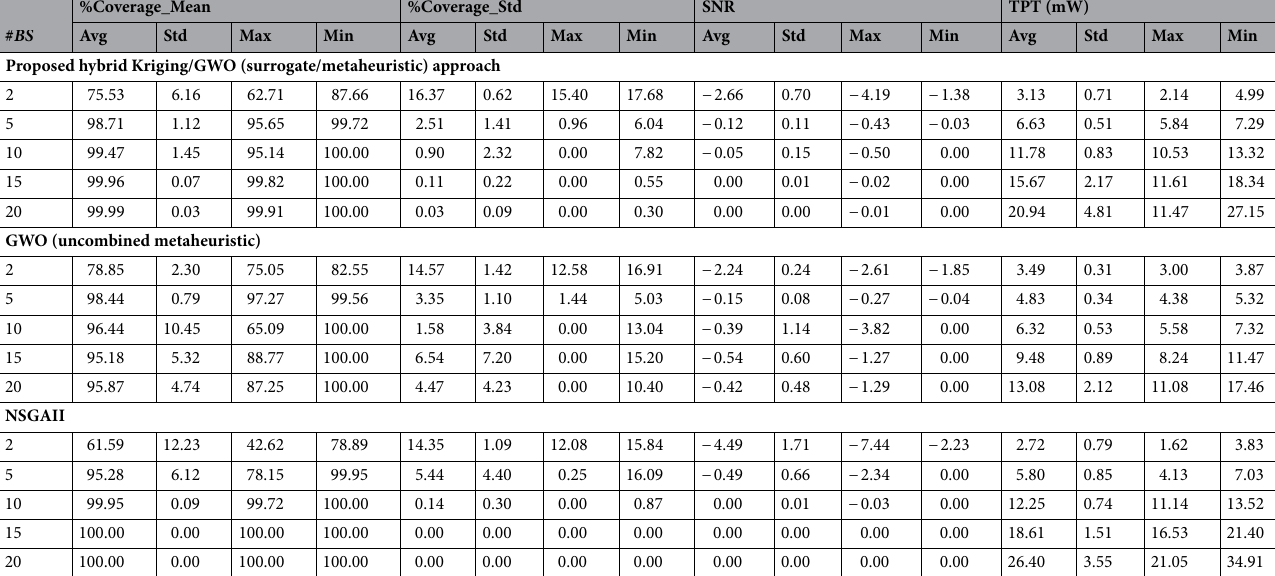
Table 4. Statistical results over 10 repetitions of the proposed Kriging-GWO (hybrid surrogate-metaheuristic) approach compare to GWO (uncombined metaheuristic) and NSGAII in robust optimal placement over